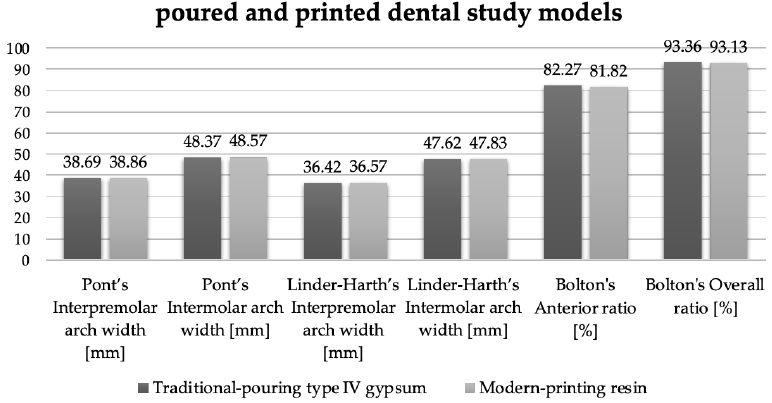
Figure 5. The average values of the evaluated indices on the experimental case study models.